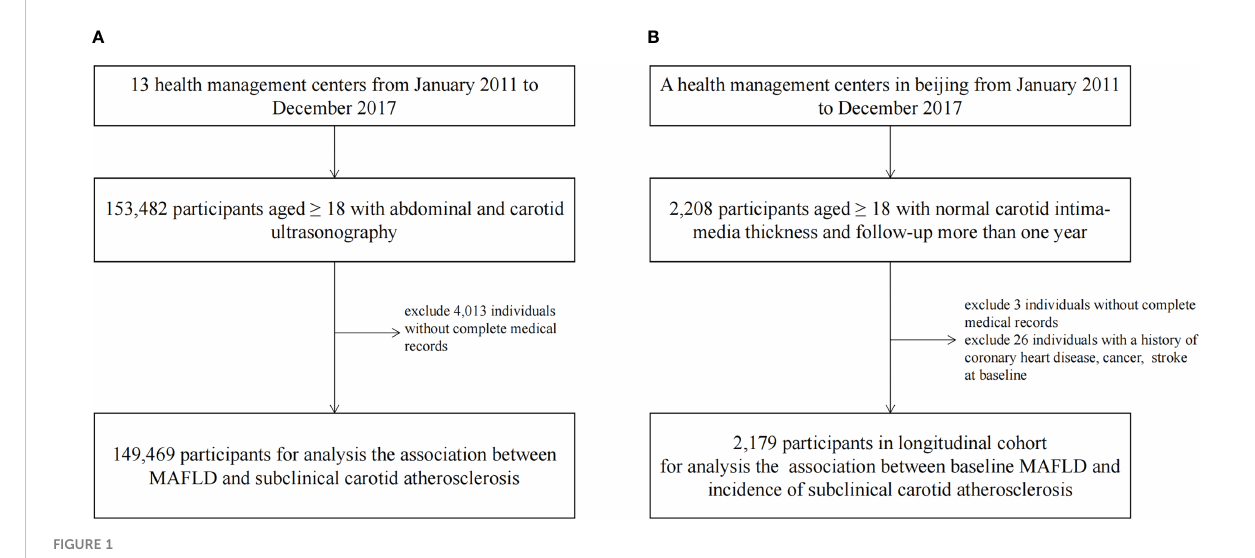
FIGURE 1 The Flowchart Showing the Strategy of Participant Enrollment. A schematic overview illustrating participants enrollment and the exclusion and inclusion criteria. (A) The fl owchart of the cross-sectional study. (B) The fl owchart of the cohort.